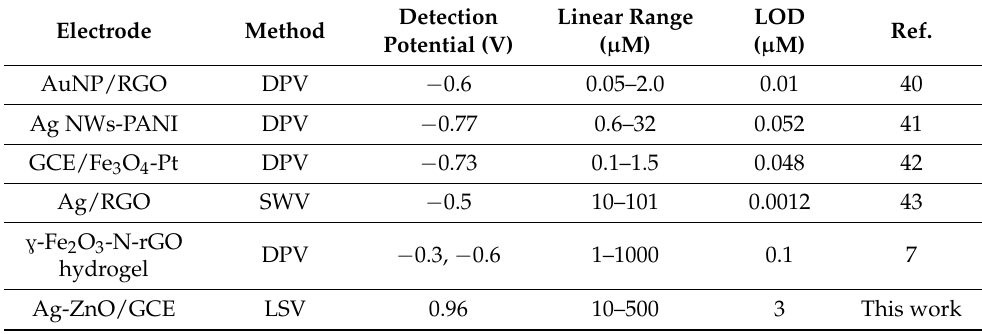
Table 1. Sensitivity comparison of the Ag-ZnO/GCE electrode on